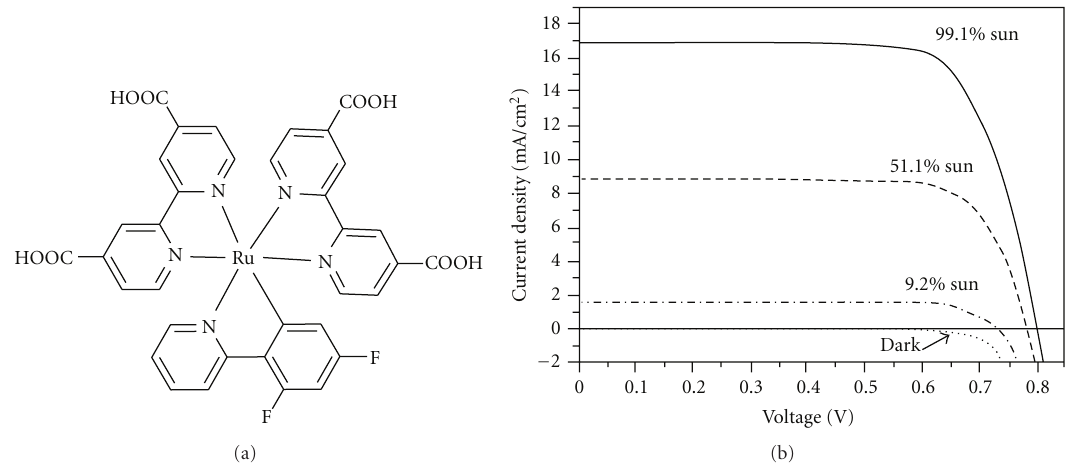
Figure 31: Molecular structure of YE05 and current density-voltage curves under various light intensities of AM 1.5 sunlight (taken from